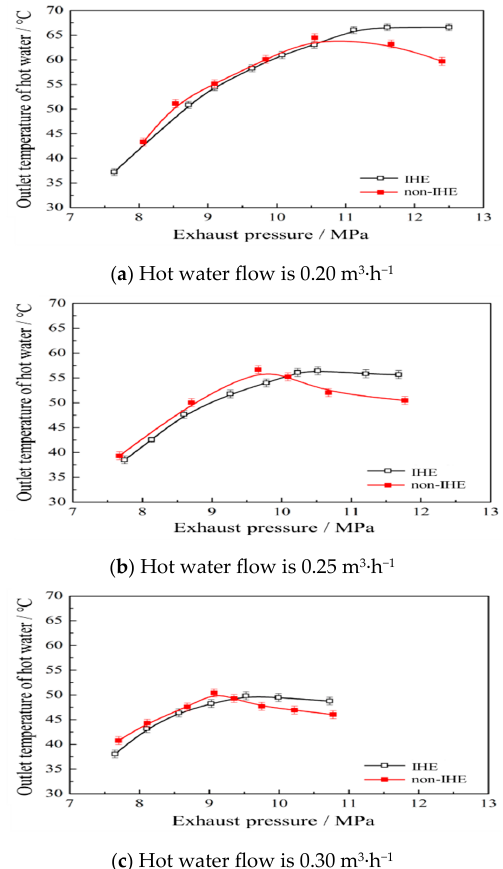
Figure 6. Comparison of outlet temperature of hot water with and without IHX at different hot water flow rates.